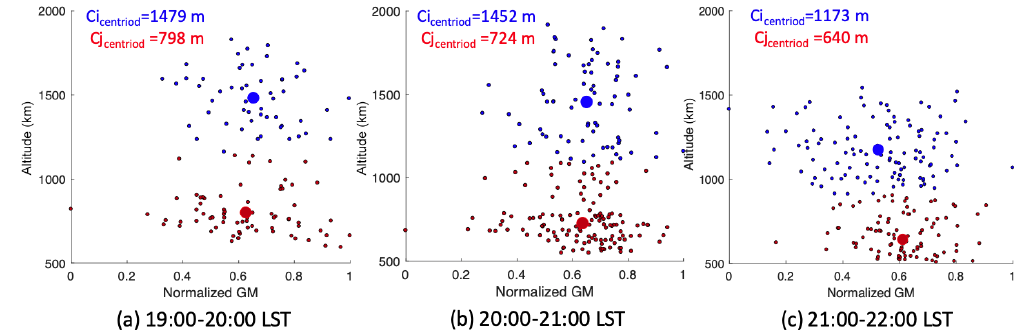
Figure 10. Distribution of altitude and the normalized gradient method (GM) value during 19:00–22:00LST.